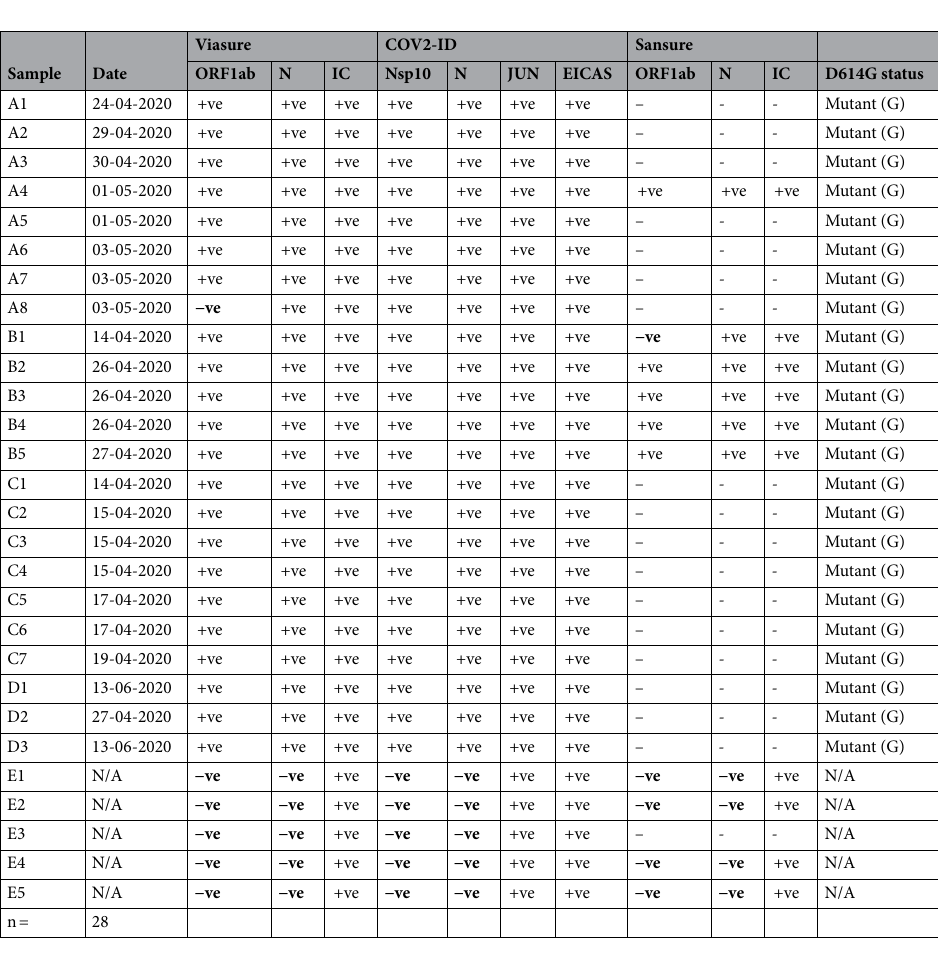
Table 3. Validation of 28 RNAs extracted from patients attending Broomfield Hospital between April and June 2020. The four positive (A-D) and single negative batches were collected at different times. Negative test results are highlighted in bold. The Viasure data were obtained at the hospital, and ten of the samples were screened using a commercial kit (Sansure). The result of the genotyping tests are also shown.